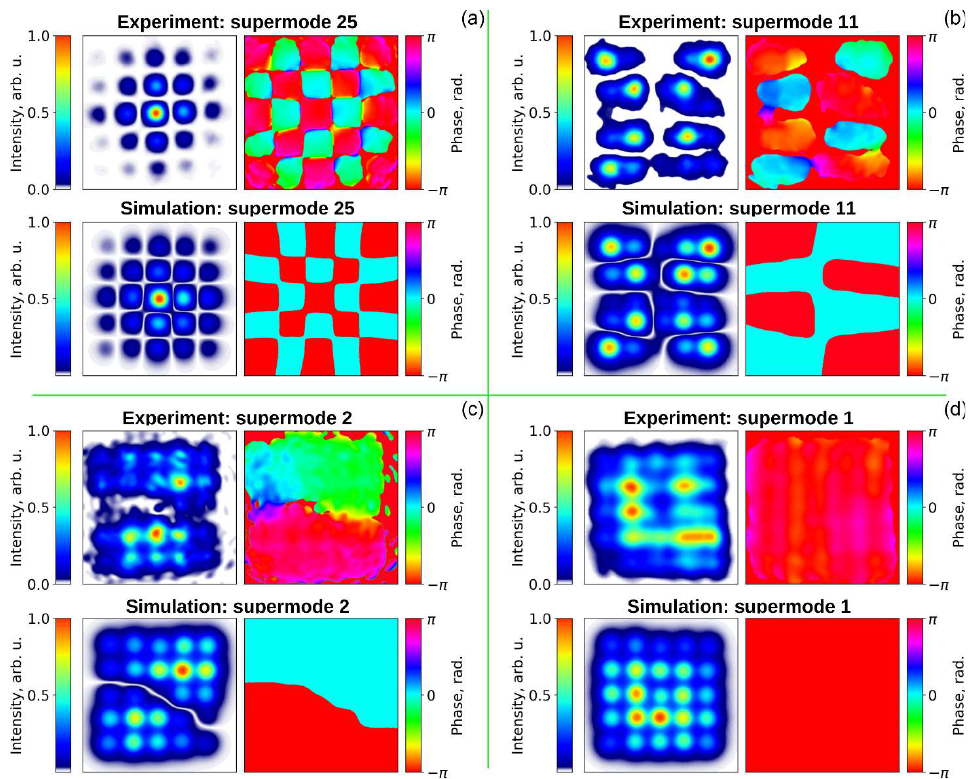
Figure 4. Measured (upper panels in each subplot) and numerically calculated ( lower panels ) intensity ( left panels ) and phase ( right panels ) distributions of supermodes 25 (out-of-phase; ( a )), 11 ( b ), 2 ( c ), and 1 (in-phase; ( d) ). 11 ( b ), 2 ( c ), and 1 (in-phase; ( d